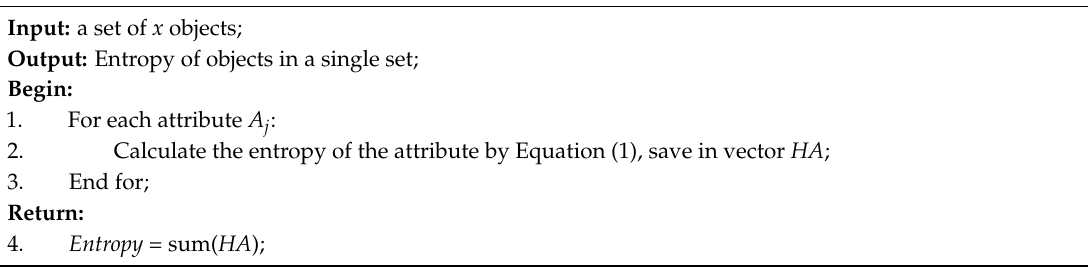
Algorithm 2 Entropy calculation